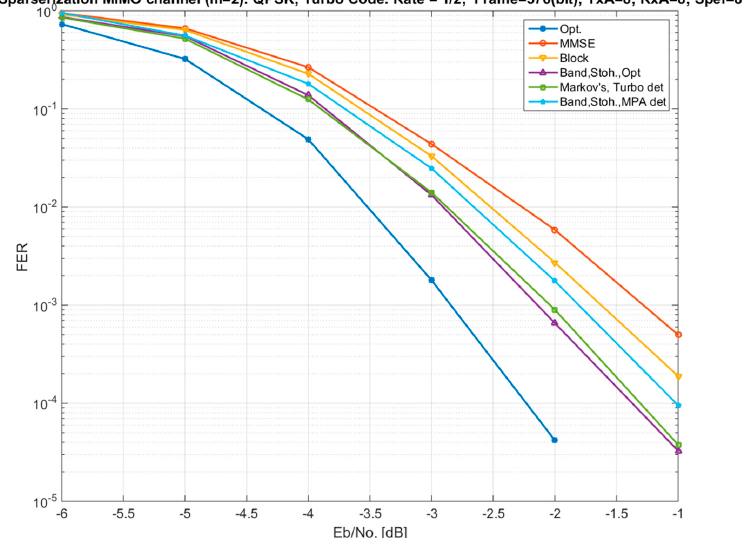
Figure 5. Dependences of the frame error rate (FER) on the signal-to-noise ratio per bit for an 8 × 8 MIMO channel with different options for channel matrix sparsification and for different detectors (QPSK modulation and Turbo code with a rate of ½).